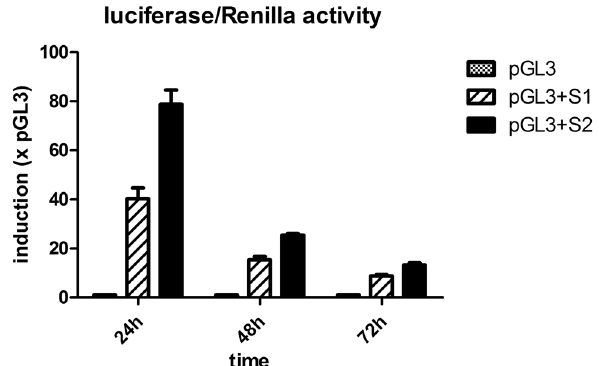
Figure 4. Relative luciferase activity of MCF-7 cells transfected with the pGL3-Basic plasmid containing promoter regions of the NRIP1 gene. Firefly luciferase was normalized to the Renilla vector (pRL-TK Renilla plasmid). The samples were collected 24 h, 48 h and 72 h after transfection. The values were compared to pGL3 (Mock), which was used as a negative control. pGL3-S1 contains proximal and distal sites, and pGL3-S2 contains only proximal sites. After 24 h, the S2 region showed twice the activity compared to the S1 region, which spans distal and proximal regions. After 48 h and 72 h, similar behavior was observed but with less intensity. Each bar represents the mean ± SD. *p < 0.05, **p < 0.01.